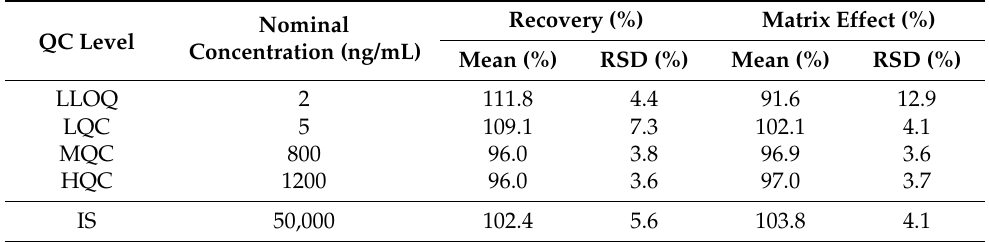
Table 3. Extraction recovery and matrix effect of SH045 in mice plasma ( n = 6).